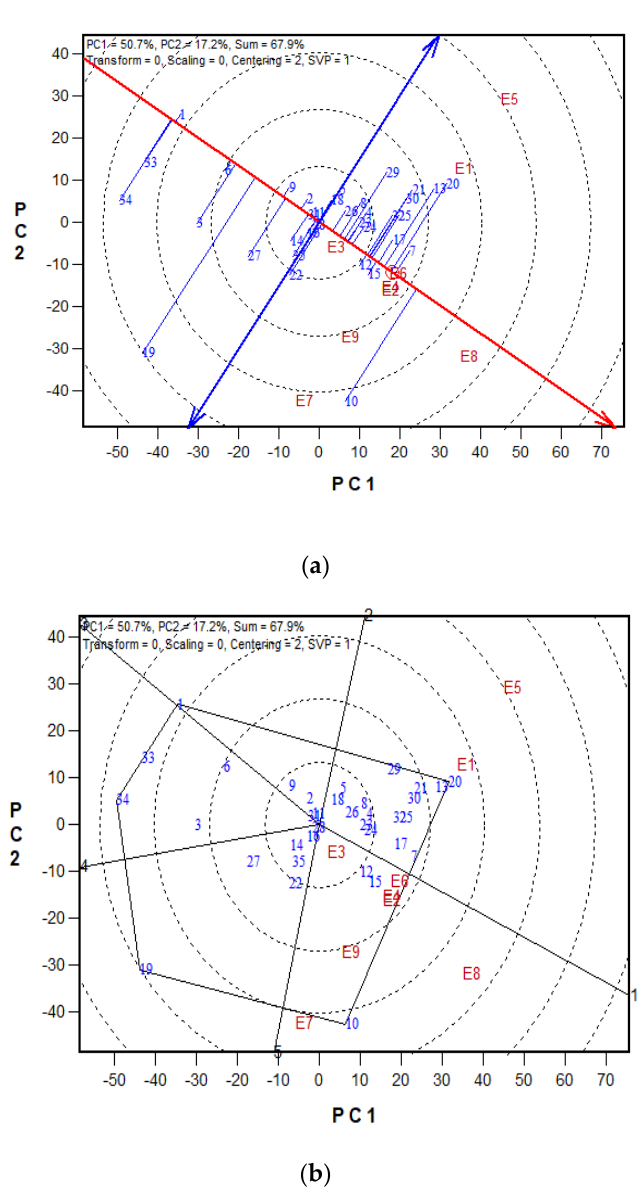
Figure 2. ( a ). The “mean vs. stability” view of the genotype main effect plus genotype × environment interaction (GGE) biplot based on genotype × environment yield data of 35 early-maturing maize hybrids evaluated in five low N environments and four high N environments in Nigeria from 2017